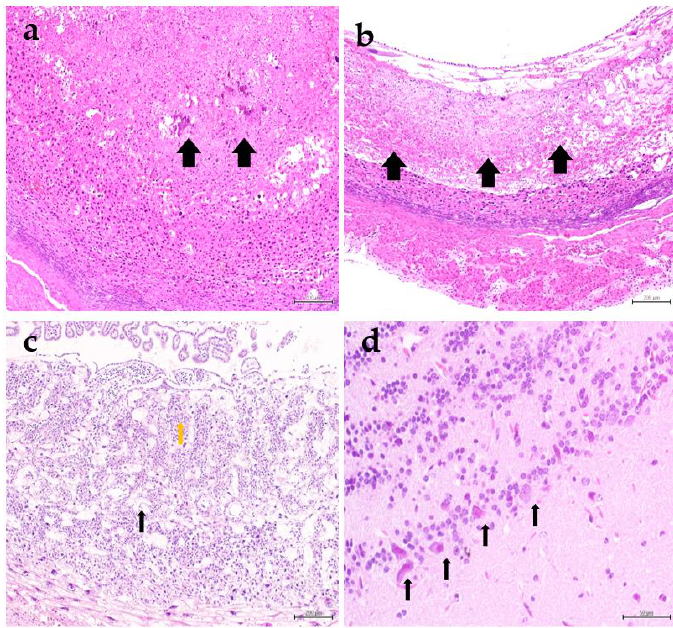
and hemorrhage of the spongiotrophoblast layer and labyrinth (orange arrow) ( c ). The neurons